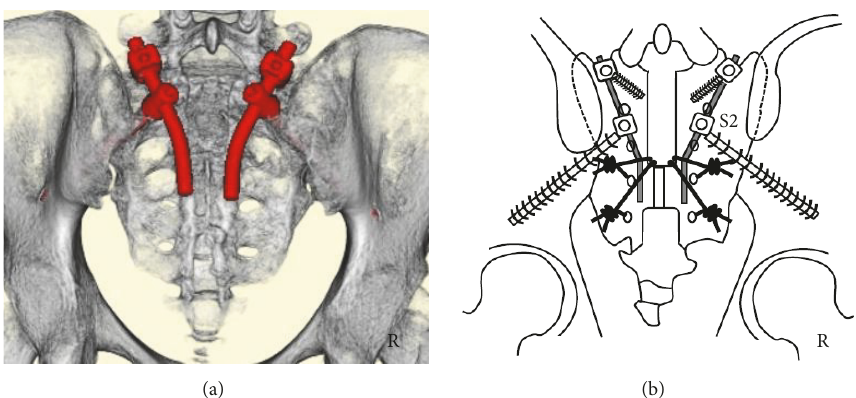
Figure 6: Postoperative three-dimensional computed tomography (CT) and schema . (a) Three-dimensional CT. (b) Operation schema. Three- dimensional CT showing S1–3 laminectomy, S1 pedicular screws, S2AI screws, and rods (red color) (a). Operation method (b): we performed S1–3 laminectomy. We then passed ultrahigh molecular weight polyethylene (UHMWPE) cables from the central laminectomy area to the third and fourth posterior sacral foramina. We inserted S1 pedicular screws and S2AI screws and connected the rods, following which the UHMWPE cables were tightened to the